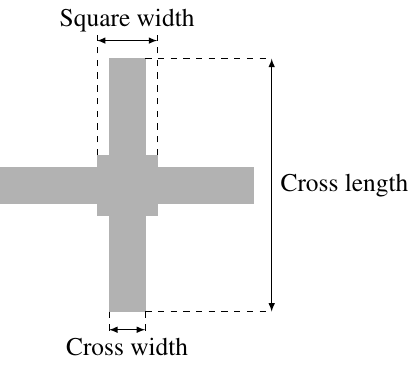
Table 3. Cross parameters according to Fig. ?? used during